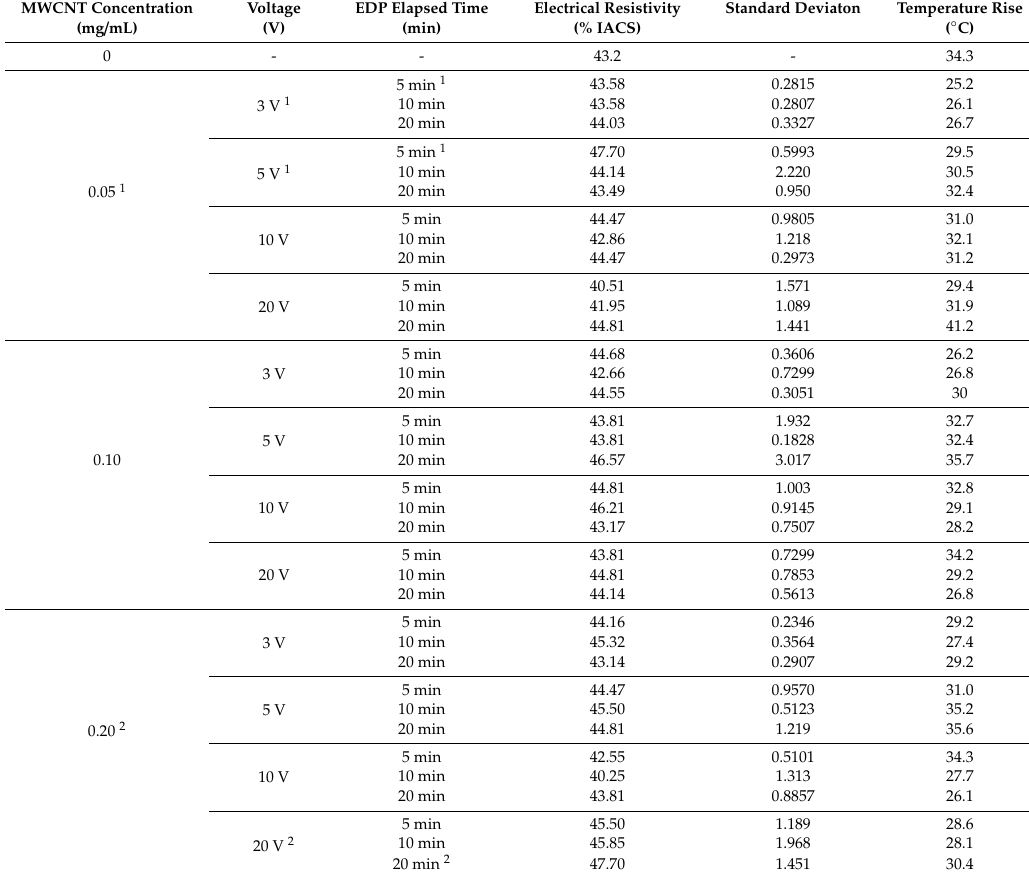
Table 1. Average of the % International Annealed Copper Standard (IACS) and maximum temperature rise obtained after deposition. The electrical conductivity on the surface commercial Al 6061 samples was increased 9.6% by the EDP when the electrodeposition was performed in a solution with a concentration of 0.05 mg / mL of MWCNTs, after the sample was deposited for 5 min and by applying a power voltage of 5 V. Temperature performance was improved by 36% when the sample was coated with MWCNTs concentration solutions of 0.05 mg / mL, applied voltage of 3 V, during 5 min. MWCNT Concentration Voltage EDP Elapsed Time Electrical Resistivity Standard